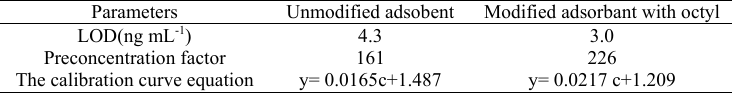
Table 4. the compaiosn between the modified and unmodified adsorbants.